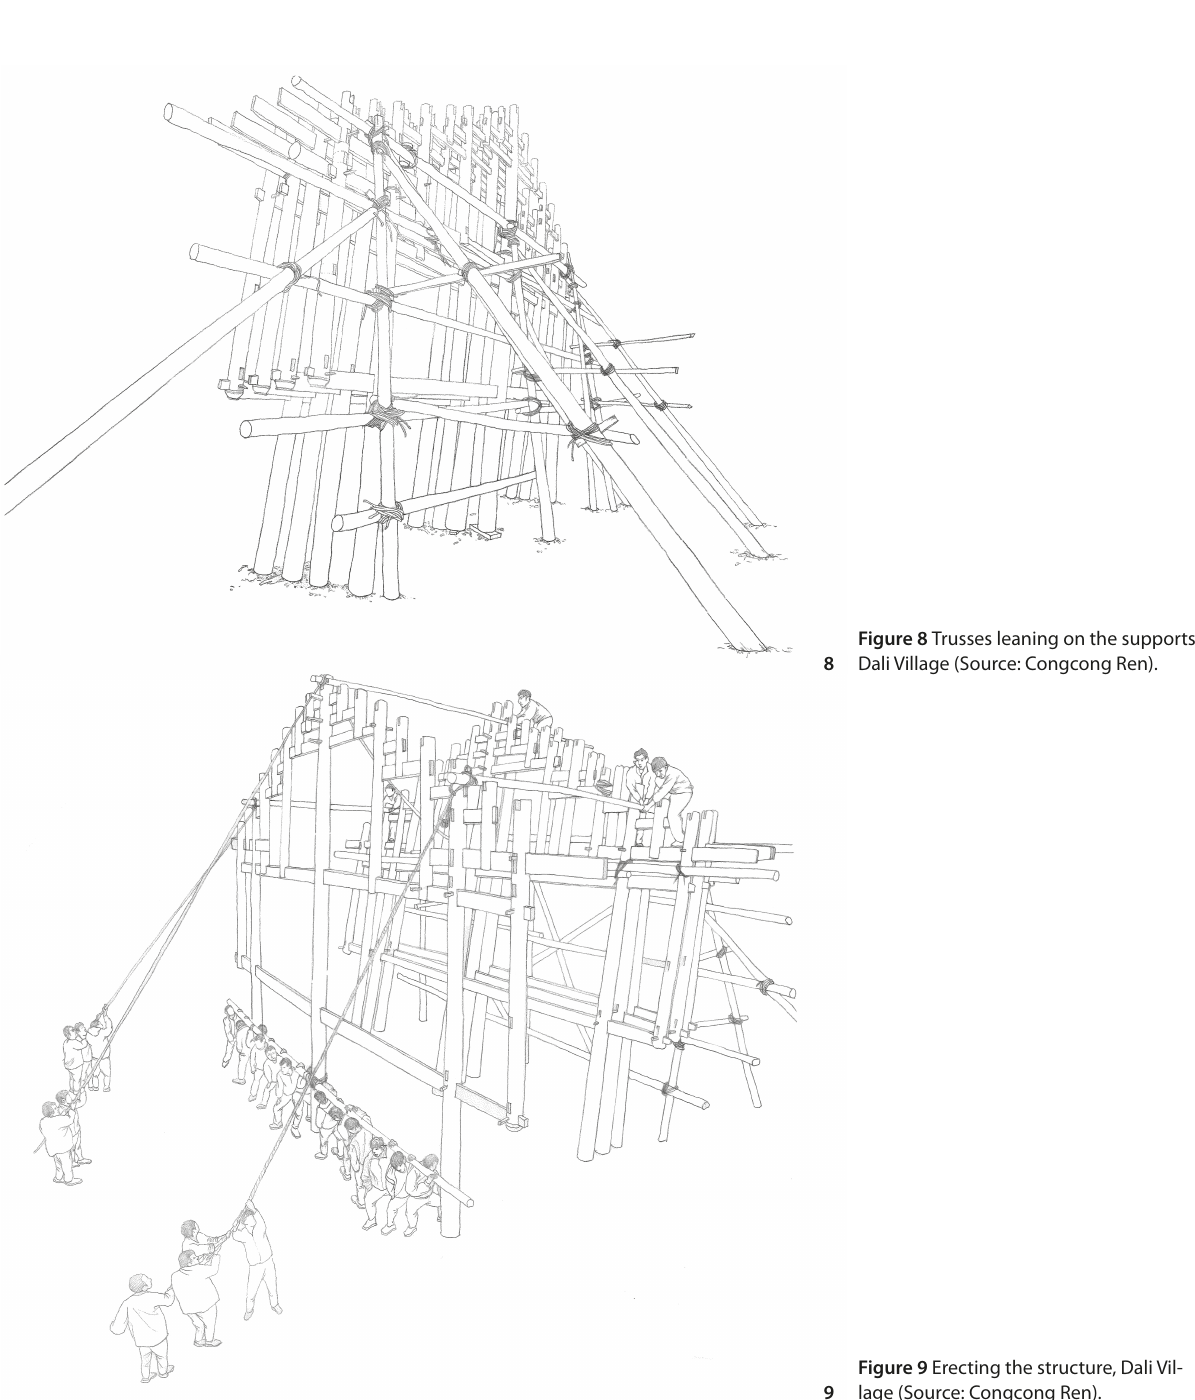
Figure 9 Erecting the structure, Dali Vil- lage (Source: Congcong Ren).